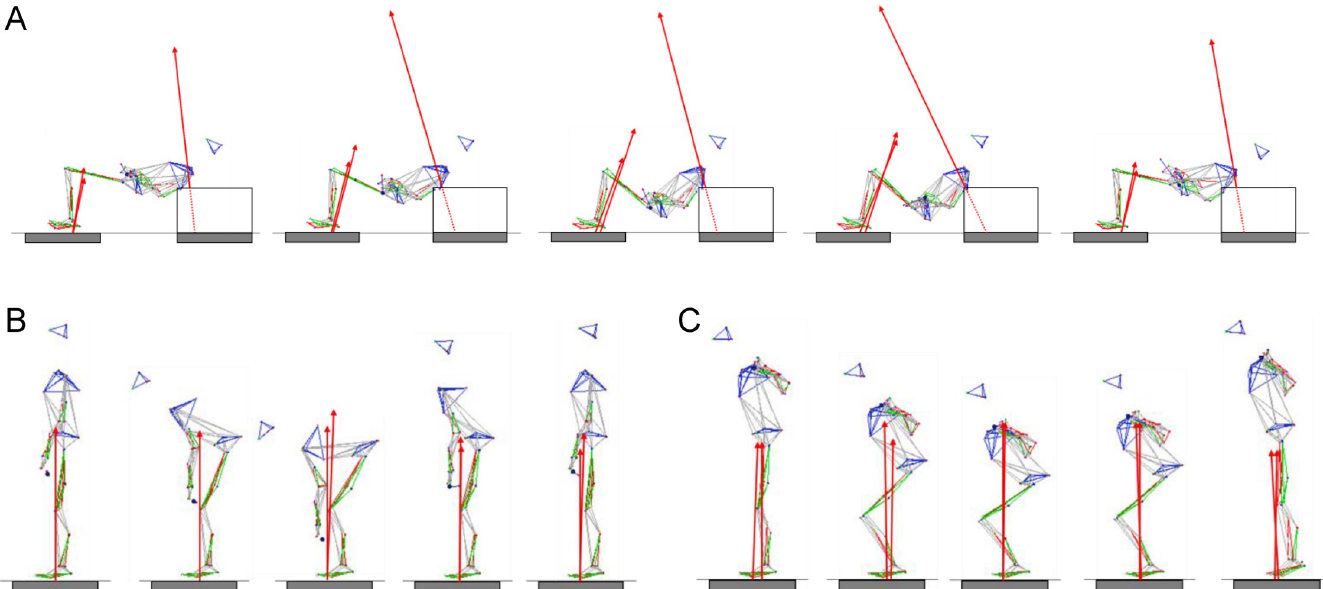
Fig 1. Typical stick postures during the barbell hip thrust (A), deadlift (B) and back squat (C). Red arrows indicate the ground reaction forces captured by force plates (grey